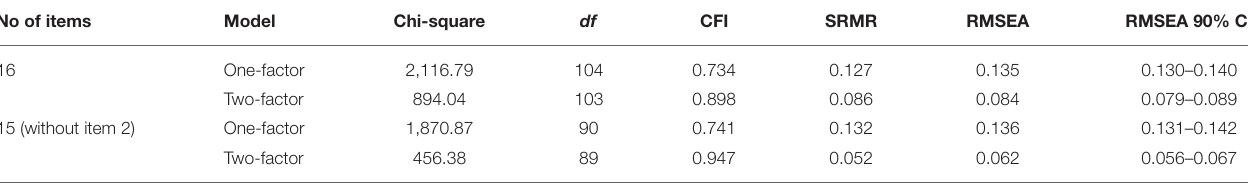
TABLE 2 | CFA fit statistics for the two structural models of the DFPS-PL (total